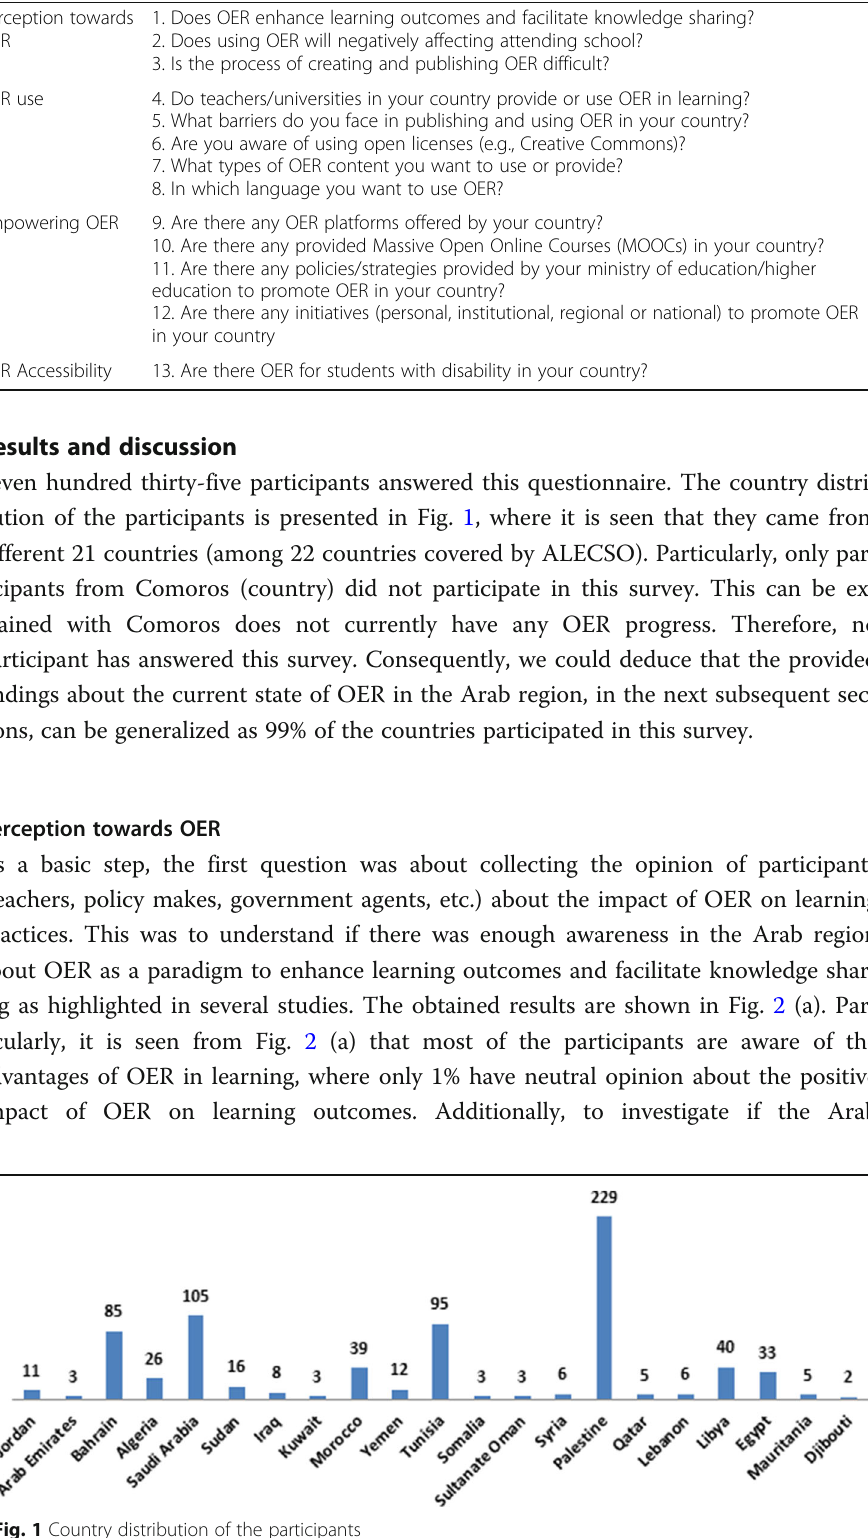
Table 1 Proposed questions within the questionnaire Dimension